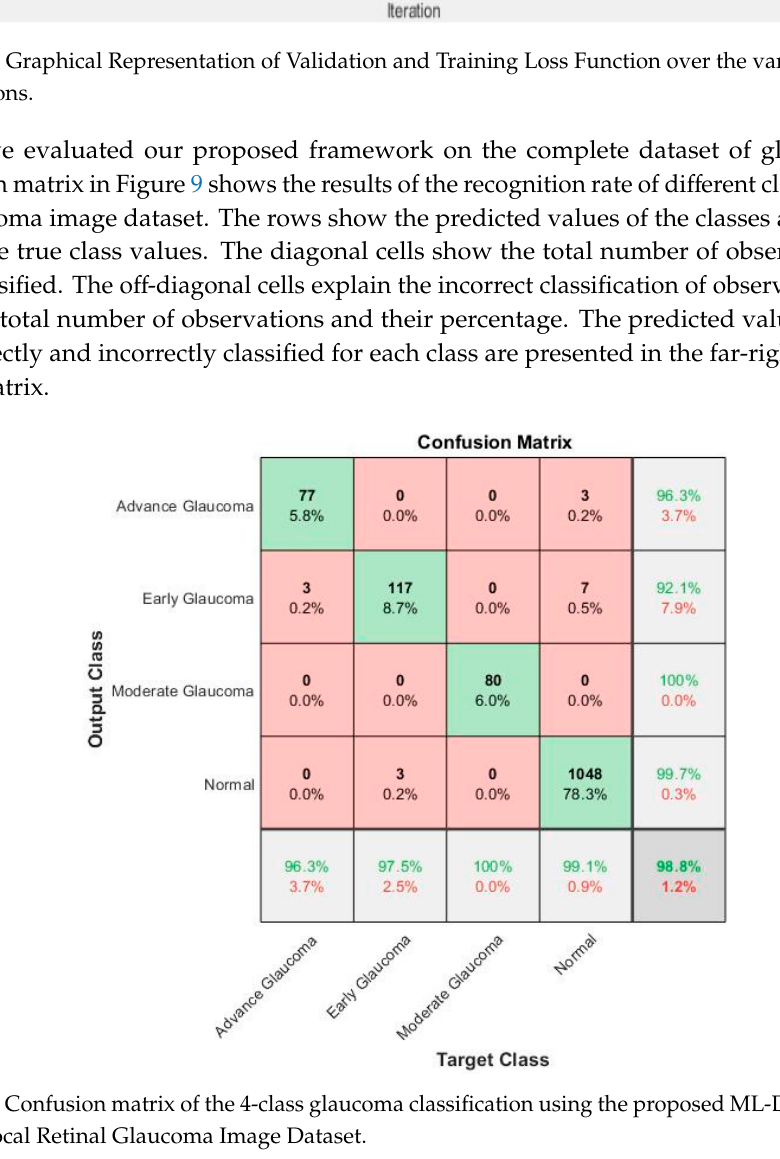
Figure 8. Graphical Representation of Validation and Training Loss Function over the various number of iterations.